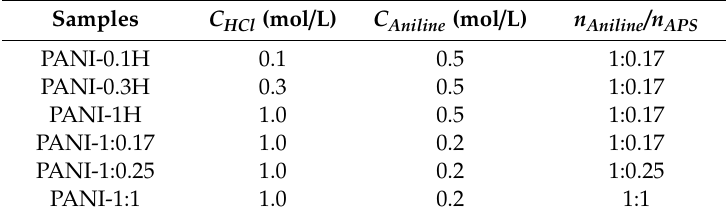
Table 1. The feed compositions of reagents for preparing PANI samples 1 . Samples C HCl (mol / L) C Aniline (mol / L) n Aniline / n APS